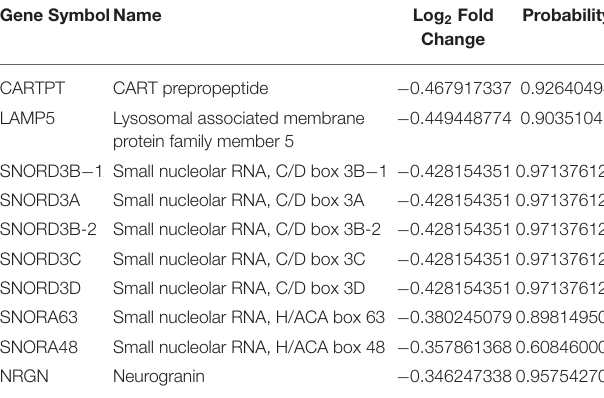
and RPS4X . The hub genes for the comparison group AsymAD vs. control are as follows: CACNG7, GRIA2,